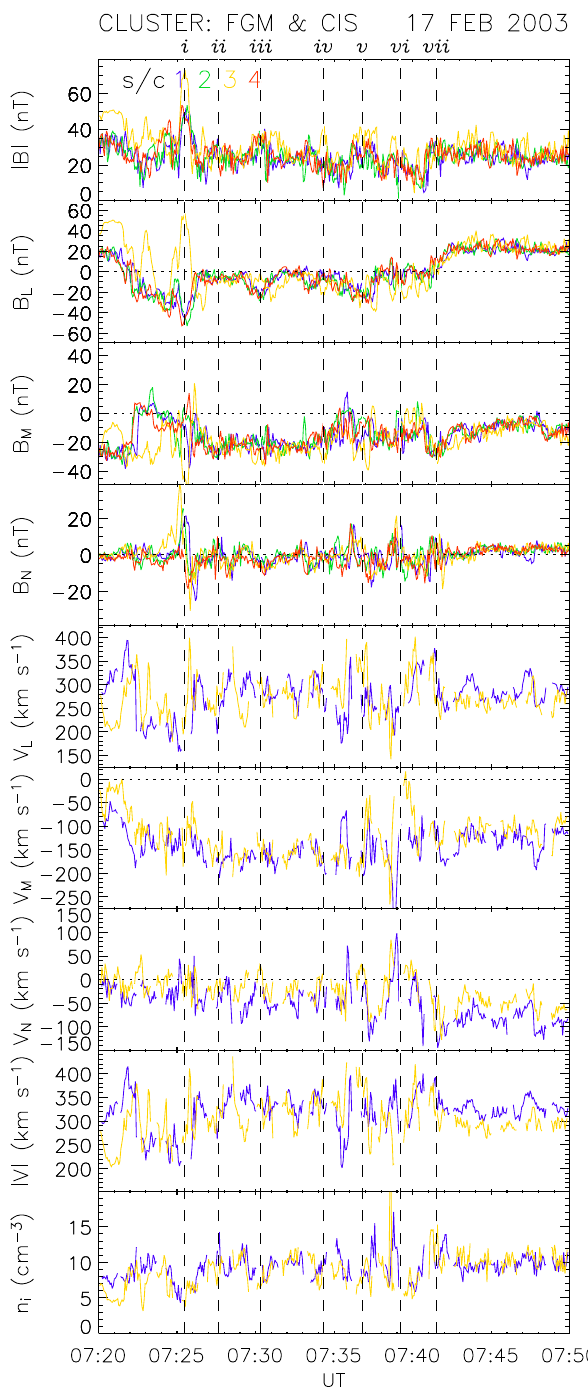
Fig. 3. Cluster magnetic field and ion observations during the inter- val 07:20–07:50 UT on 17 February 2003, colour-coded according to spacecraft. From top to bottom, the panels present the total mag- netic field strength, the L , M , and N components of the magnetic field and the corresponding L , M , and N components of the ion ve- locity (as described in the text), the total ion velocity, and the local ion concentration.